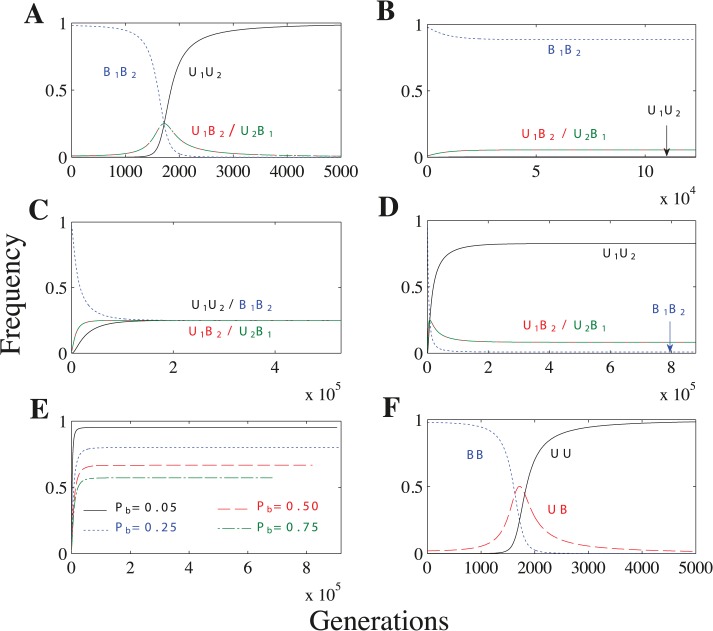
Recombination and no mating types scenarios.Parameters: n = 20, μ = 10−4, c
h = 0.2. (A) As the U allele initially spreads (generations 0–1700), the U
1
B
2/U
2
B
1 genotypes increase in frequency. But, because U
1
B
2 and U
2
B
1 cells lead to B
1
B
2 cells through meiosis and random mating, the U
1
U
2 genotype soon takes over and uniparental inheritance becomes fixed. Additional parameters: P
r = 0.5 and concave fitness. (B) Biparental inheritance dominates when U × U matings are biparental and fitness is concave. (C) Uniparental inheritance invades to its maximum value (0.5) when U × U matings are biparental and fitness is linear or convex. (The frequency of uniparental inheritance is the sum of U
1
U
2 and U
2
B
1.) Additional parameters: linear fitness. (D)
U × U matings have a mixture of uniparental and biparental inheritance. Unlike in B, U
1
U
2 no longer becomes fixed because some U × U matings now have biparental inheritance and further increasing U
1
U
2 would only increase the overall level of biparental inheritance. Additional parameters: P
b = 0.1 and linear fitness. (E) Lines represent the frequency of uniparental inheritance in separate simulations with linear fitness and varying probabilities of biparental inheritance (P
b) when U × U matings have a mixture of uniparental and biparental inheritance. As P
b increases, U × U matings are more likely to lead to biparental inheritance, which decreases the frequency of uniparental inheritance at equilibrium. (F) No mating types scenario under concave fitness. F is identical to A except that the frequency of UB in F is the sum of the U
1
B
2 and U
2
B
1 freqencies in A.